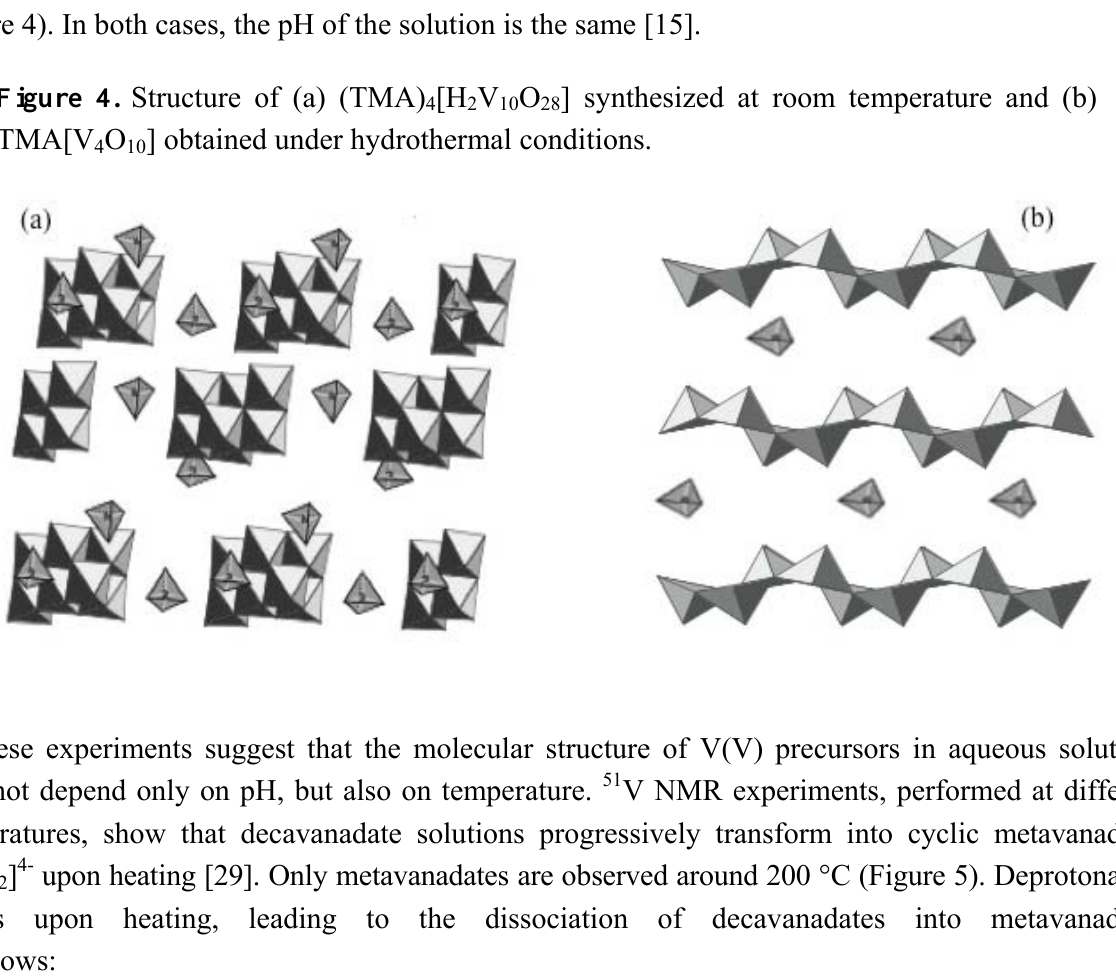
[H V O ] synthesized at room temperature and (b) 4 2 10 28